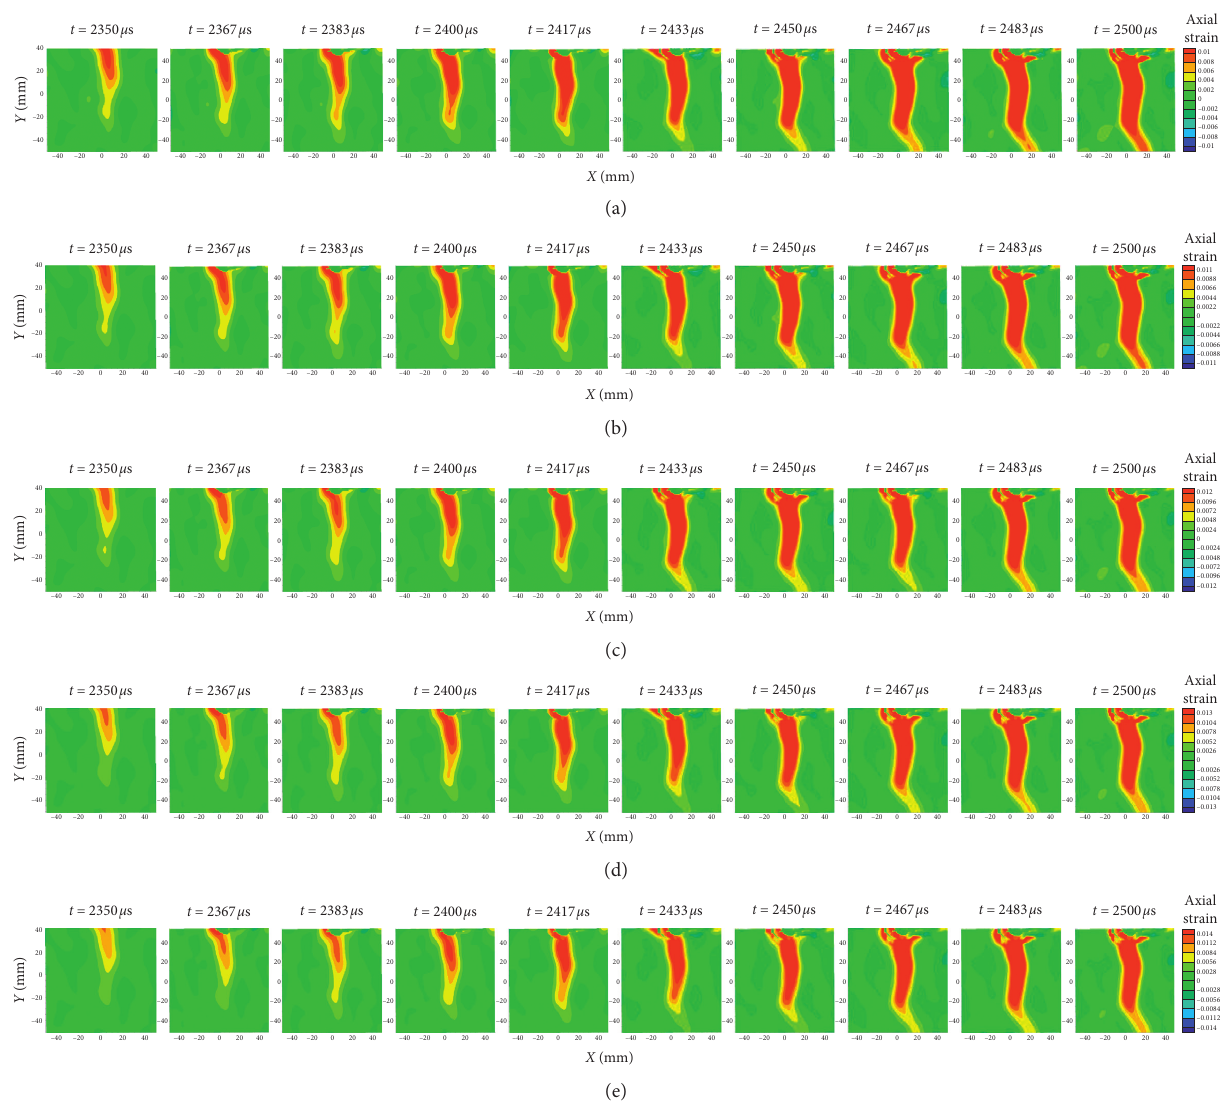
Figure 11: Evolutionary process of axial strain for different strain threshold values for test 1. (a) 1.0%, (b) 1.1%, (c) 1.2%, (d) 1.3%, and (e) 1.4%.